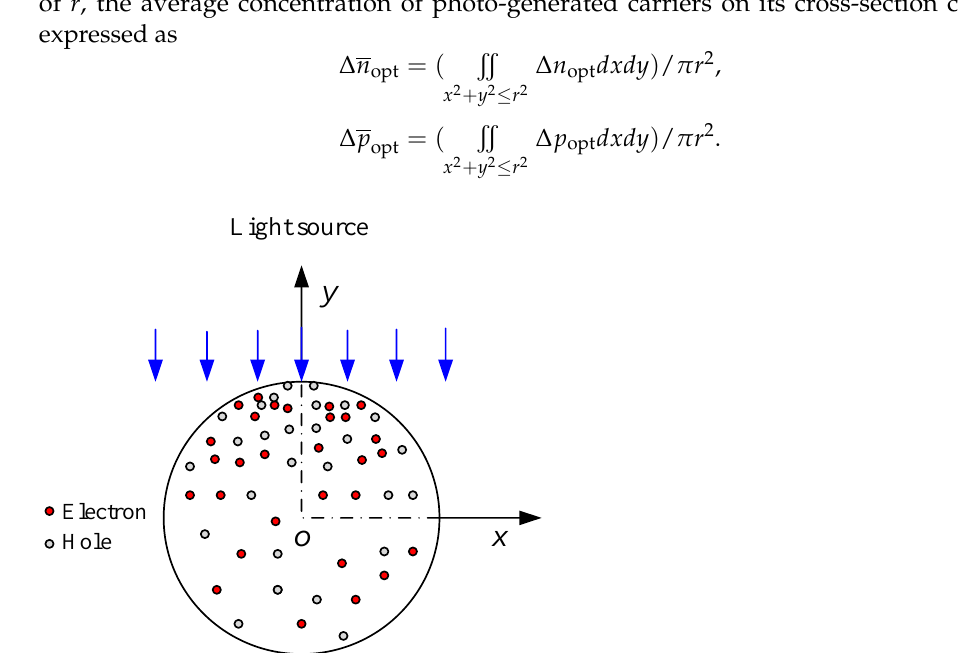
Figure 1. A schematic attenuation diagram of photoexcited carriers with the transmission depth under incident light.